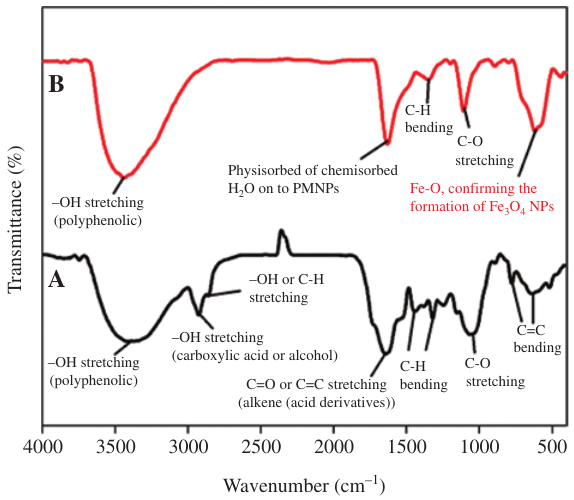
Figure 3: The Fourier transform infrared (FTIR) spectrum of (A) plant extract; (B) fabricated phytogenic magnetic nanoparticles (PMNPs). Reproduced from Ali et al. (2018) with permission from Royal Society of Chemistry, UK.